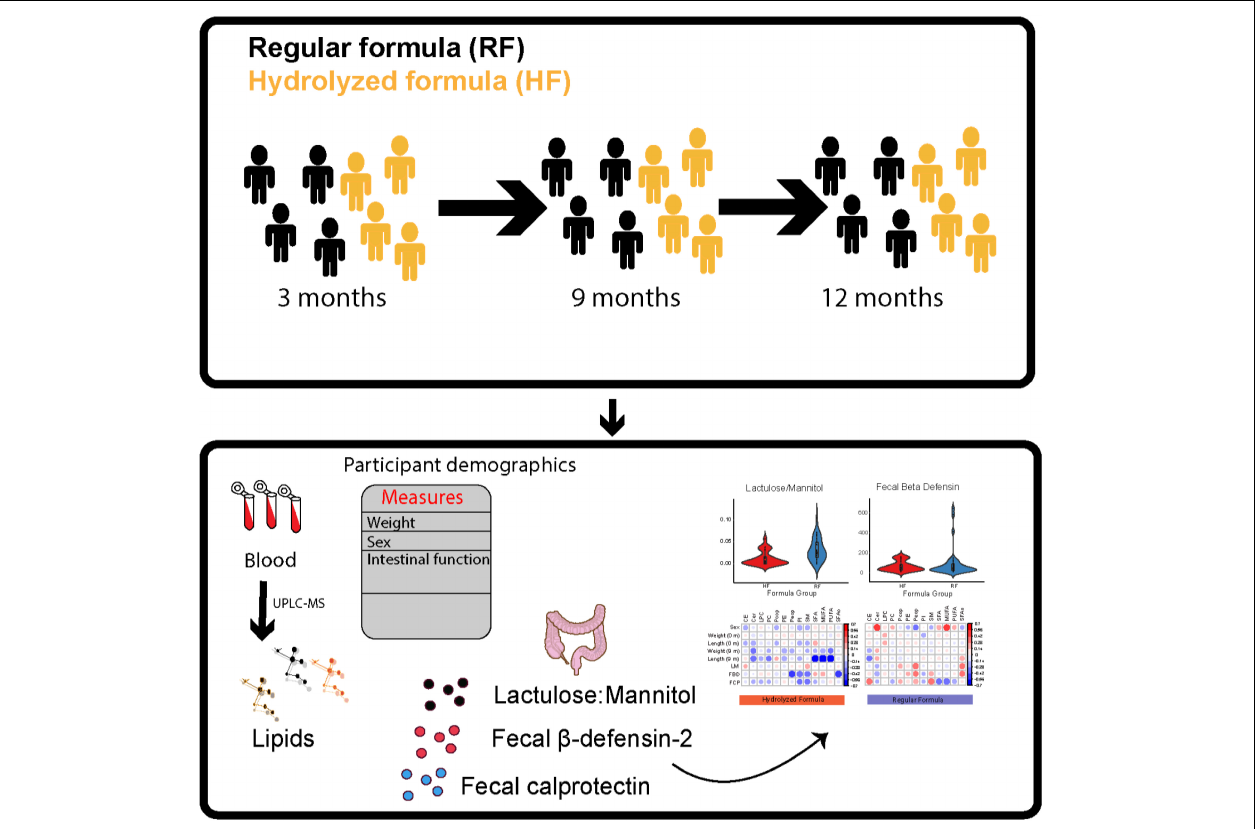
FIGURE 1 | An overview of the study setting. Serum samples for lipidomic analysis were obtained from the Early Dietary Intervention and Later Signs of Beta-Cell Autoimmunity: Potential Mechanisms (EDIA) study which is a small-scale intervention trial comparing weaning infants onto an extensively hydrolyzed milk formula vs. a conventional cow’s milk-based formula. The study groups were matched by human leucocyte (HLA)-associated diabetes risk and period of birth. For each child, longitudinal samples were obtained corresponding to the ages of 3, 9, and 12 months. These age groups were selected with the objective of understanding the longitudinal lipid profiles in infants change after ingesting extensively hydrolyzed infant formula or conventional regular infant formula. Only, those children with information about amount of study formula per day were included in the data